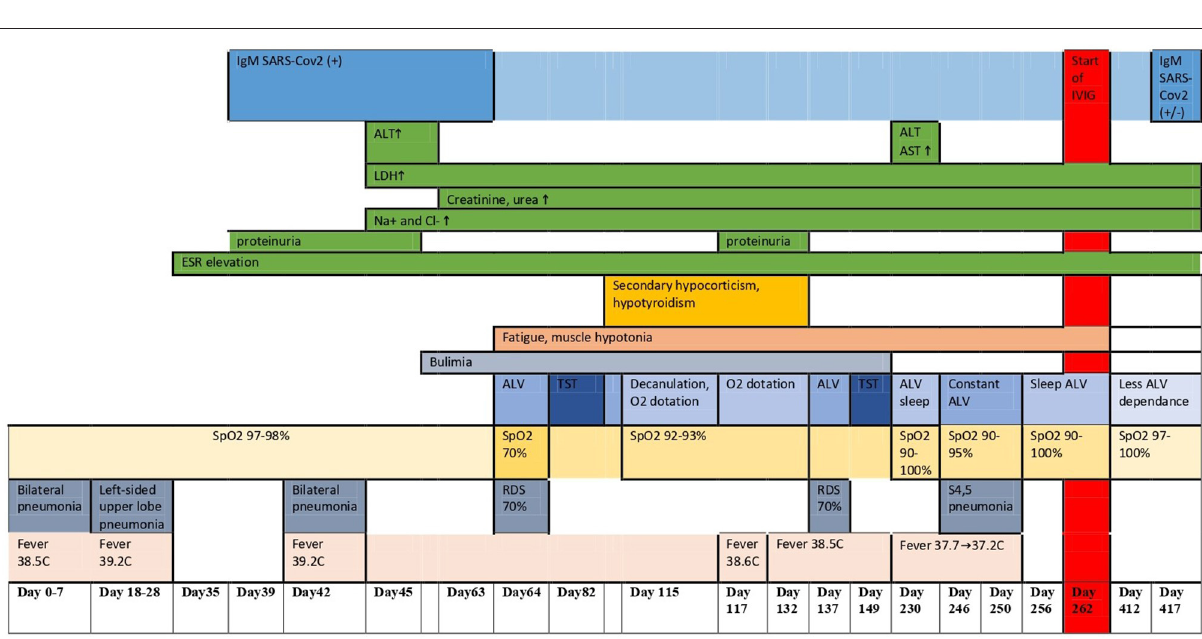
findings, and imaging allowed us to define the condition as Figure 2 and Table 1